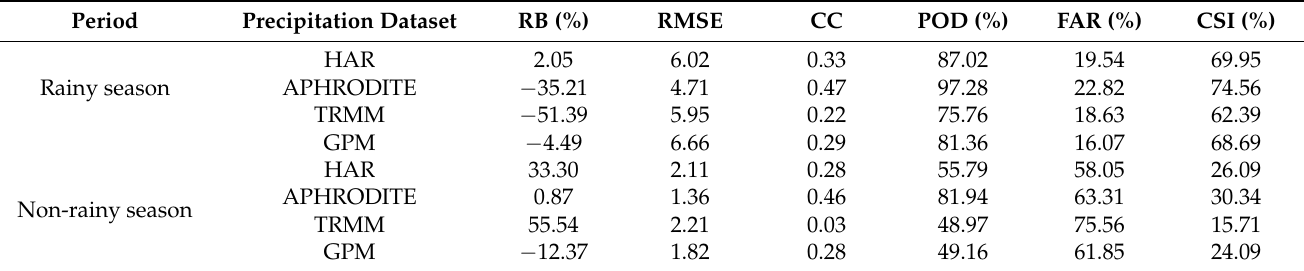
Figure 4. Box plots of grid-based statistical metrics at daily scale for years 2001–2013: ( a ) RB, ( b ) RMSE, ( c ) CC, ( d ) POD, ( e ) FAR, and ( f ) CSI. The number at the base of the box plot is the median value of each statistical metric. The short dash line in box plots denotes the mean value of statistical metric. The green horizontal line indicates the optimum value. The symbol “+” in box plots represents the outlier of statistical metric value. Table 6. Statistical indices’ median values during rainy and non-rainy